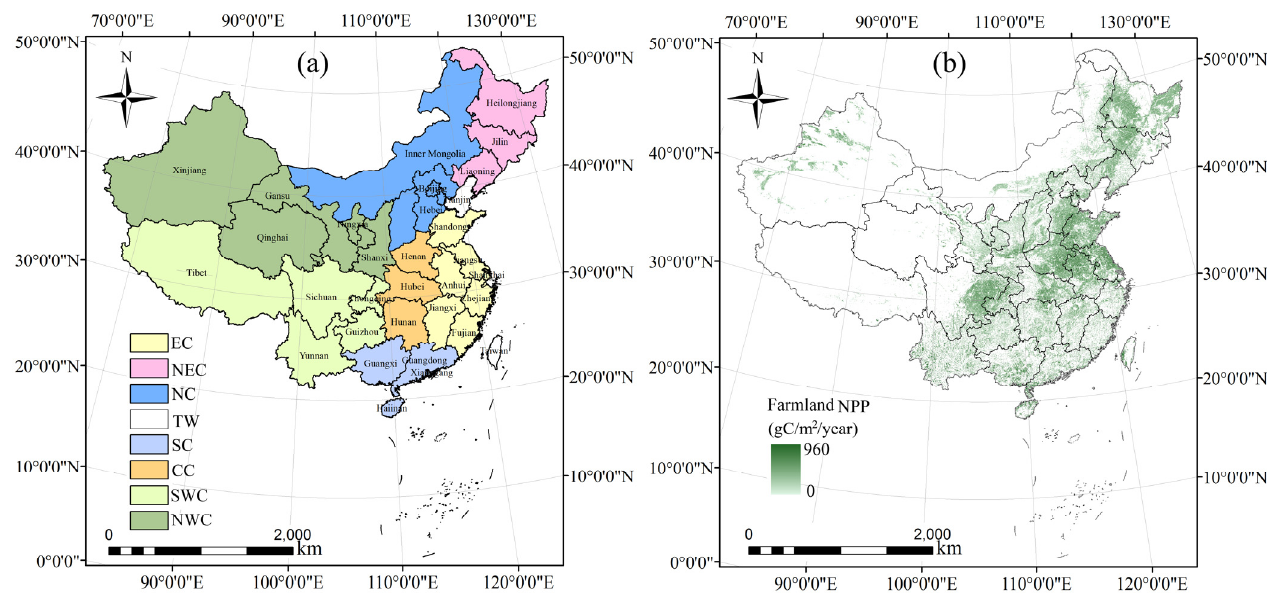
Figure 1. Geographical division (a) and farmland distribution (b) in China (2020).